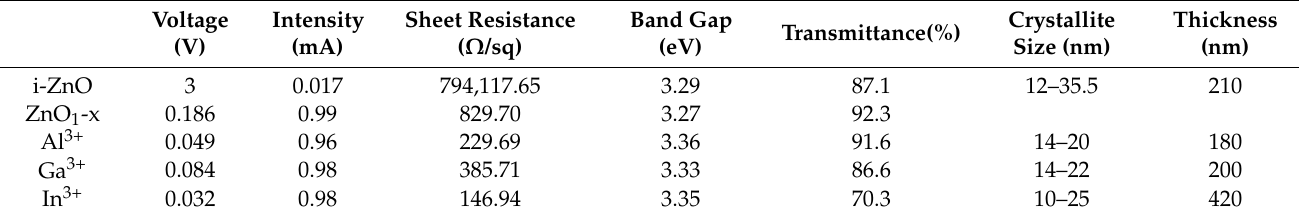
where k is Scherrer constant (0.9 for spherical particles), λ the X-ray wavelength (1.5405 Å), β the peak width of half-maximum, and θ is the Bragg diffraction angle [20]. The resultant particle size for ZnO films is between 12nm and 35.5 nm and becomes shorter for doped films as can be seen in Table 1. Table 1. Optical and electrical properties of doped ZnO grown at soda-lime glass.